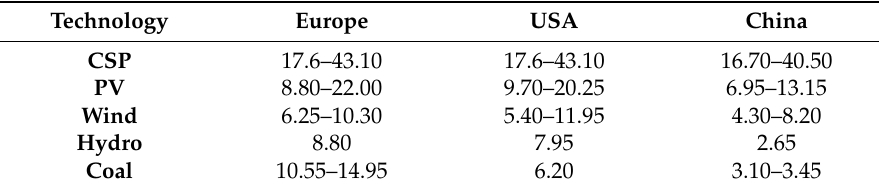
Table 2. LCOE estimates ( € c/kWh) [55,63–68].